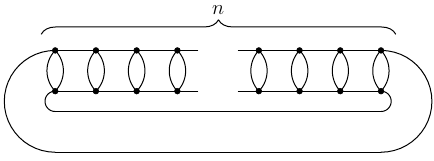
Figure 6 . A generic NNLO vacuum 2PI diagram having the form of a closed ladder with n ≥ 2 rungs, and vertices corresponding to the tetrahedron interaction. Similar diagrams but with a twist in the rails, thus forming a Möbius strip, appear only at lower order in N .